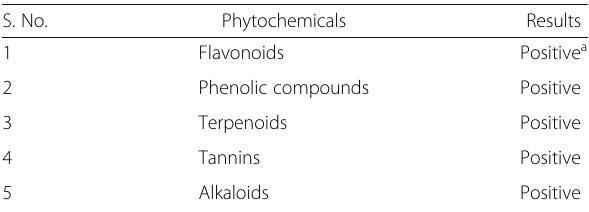
Table 4 Presence of phytochemical components in S. cumini methanolic leaves extract S. No.